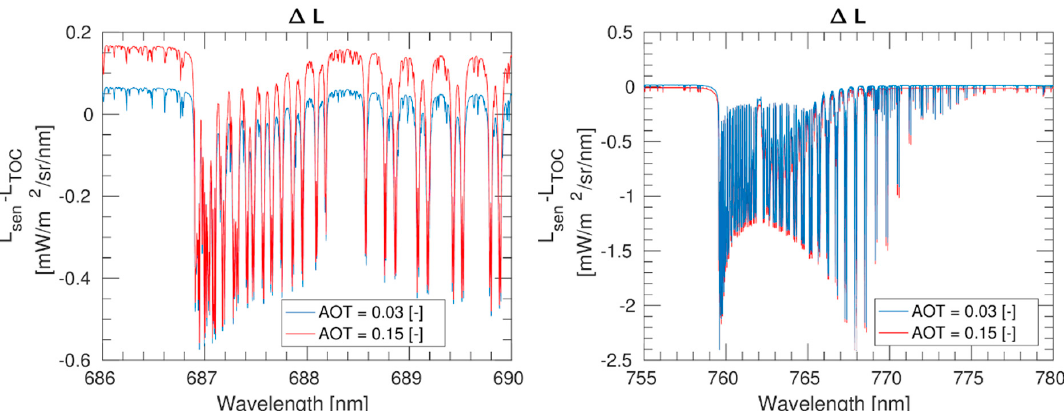
Figure 7. Difference in radiance units between radiance simulated at the UAV level (100 m) and at the TOC level (0 m) for the O 2 -B region (left) and the O 2 -A region (right). Simulations were performed with the MODTRAN 5.02 RTM using the mid-latitude summer atmospheric model and the default rural aerosol model at a spectral resolution of 1 cm-1, i.e., around 0.05 nm at the O 2 -B and 0.06 nm at the O 2 -A.